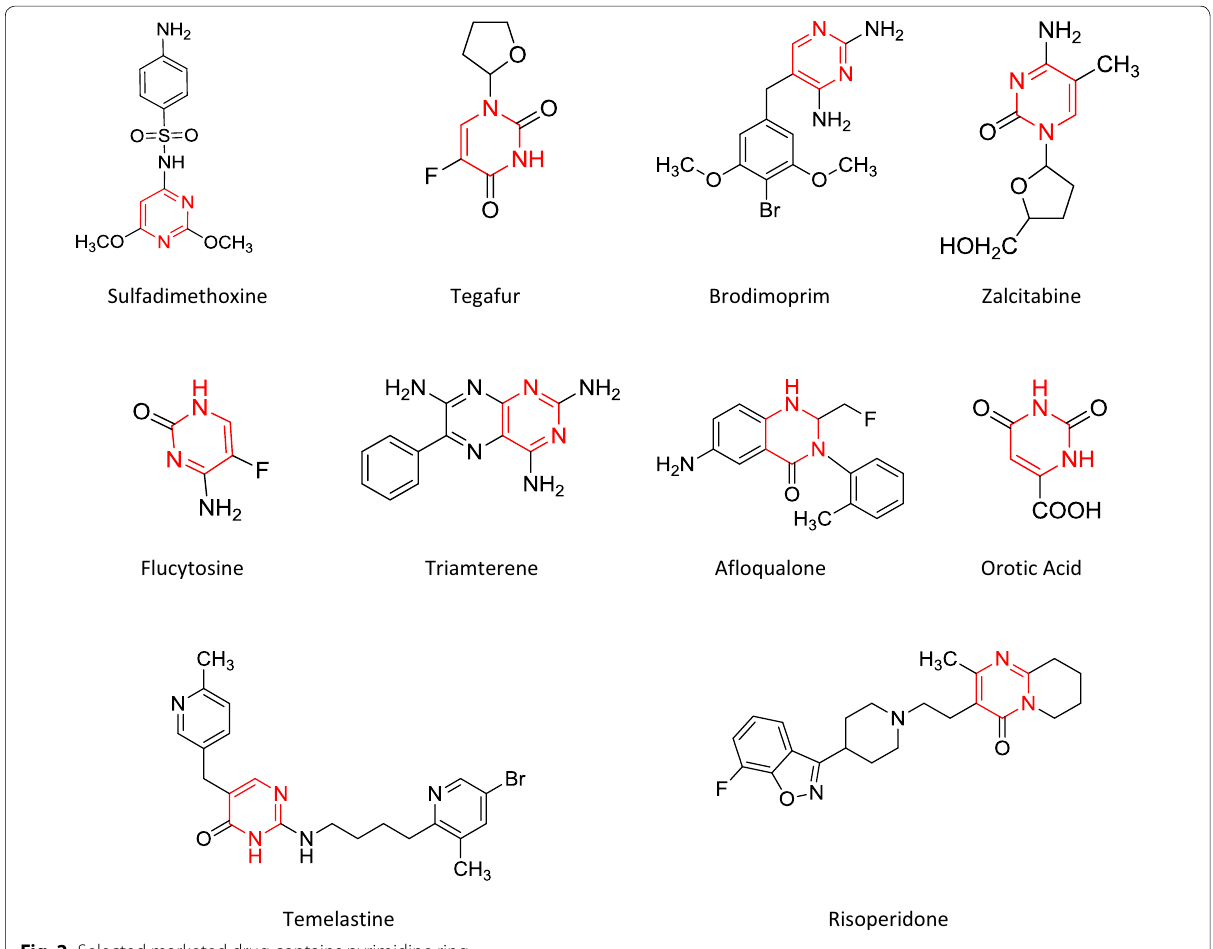
Fig. 2 Selected marketed drug contains pyrimidine